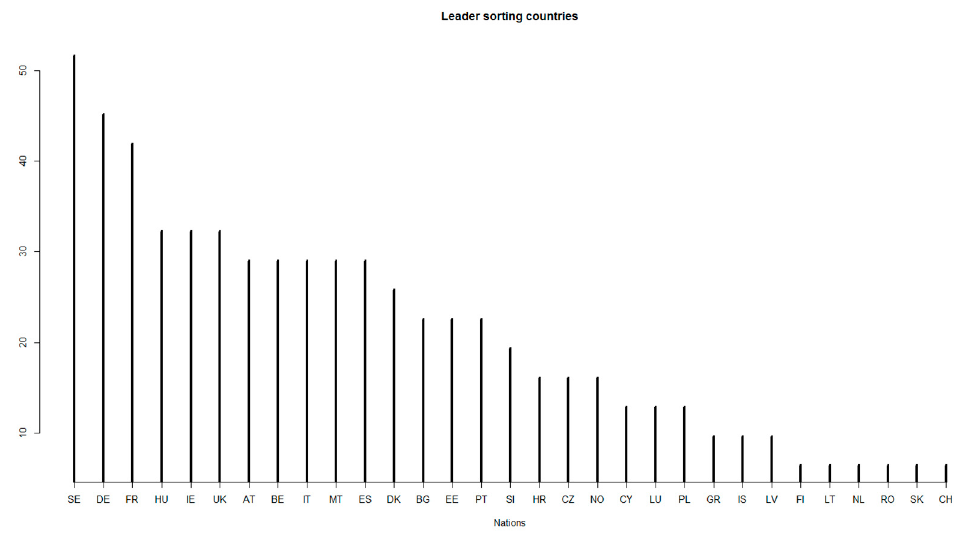
Figure 5. Ranking of leader countries.